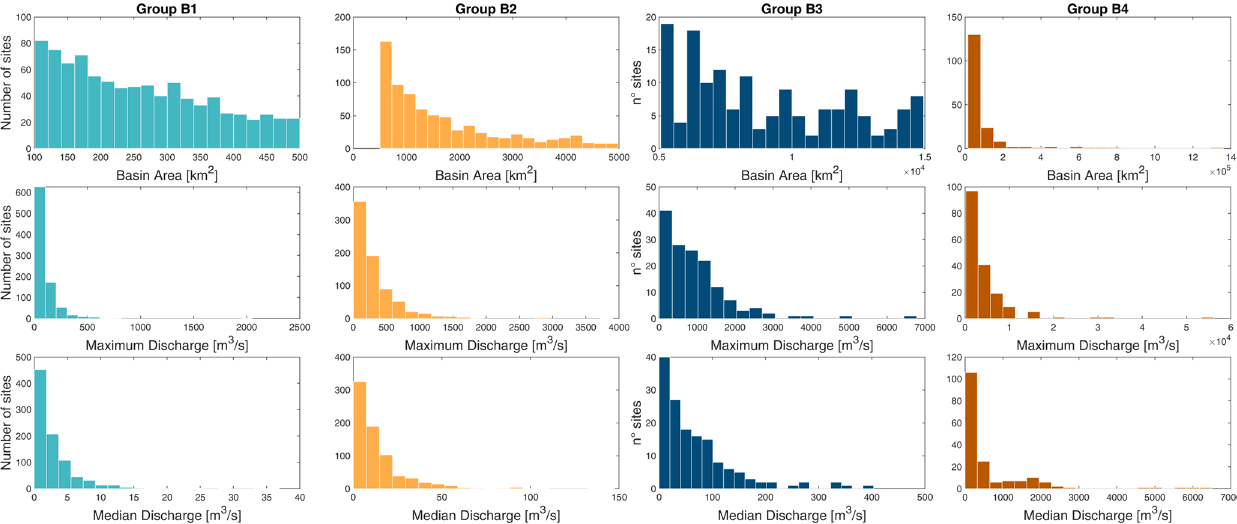
Figure 2. Histograms of the basin area (km 2 ) (top panels), maximum river discharge (m 3 s − 1 ) (middle panels) and median discharge (m 3 s − 1 ) (bottom panels) of the ground European dataset. The 1957 stations are divided in four groups based on the basin area: Ab: B1 (Ab < 500km 2 ) , B2 (500 < Ab < 5000km 2 ), B3 (5000 < Ab < 15000km 2 ) and B4 (Ab > 15000km 2 ).